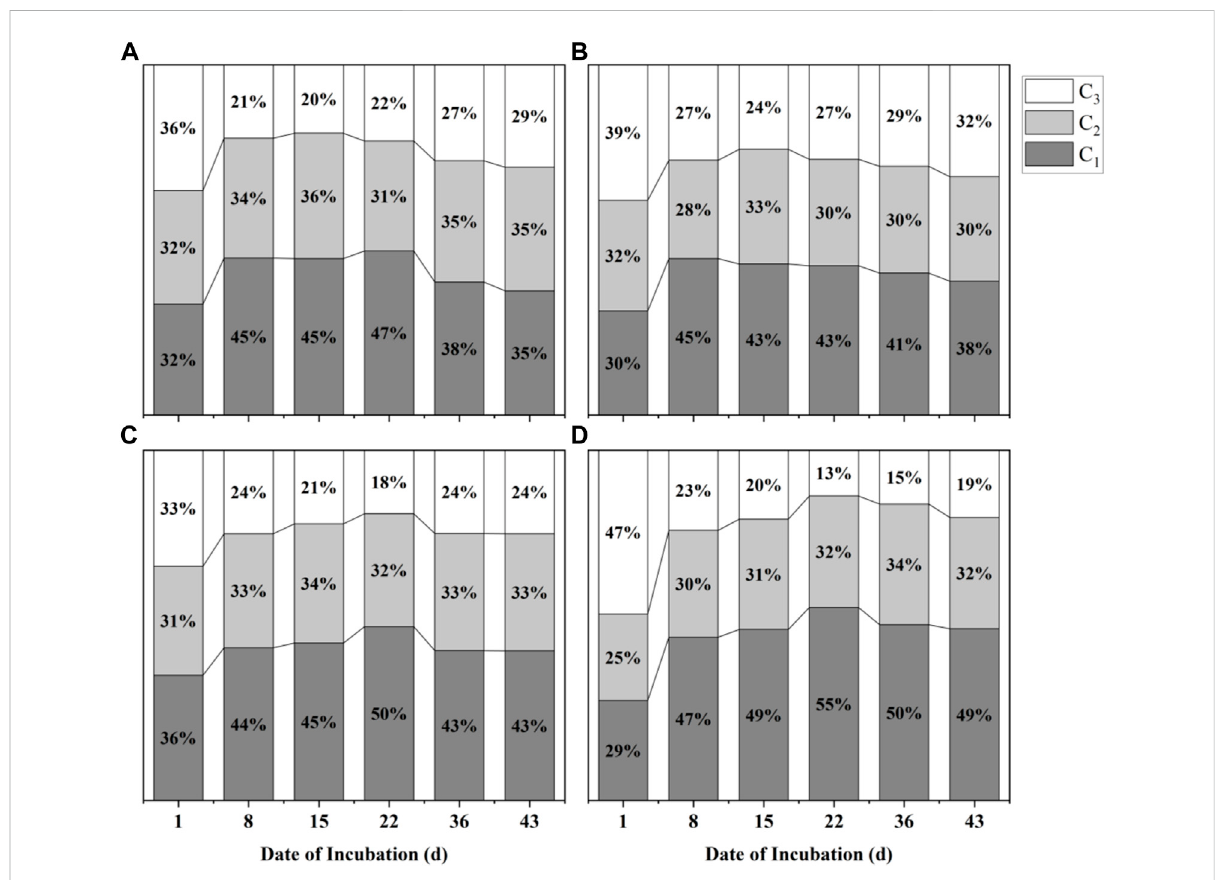
FIGURE 5 Temporal variation of organic components (%; C 1 , C 2 and C 3 ) from four sediments are plotted against time, where (A – D) represent the Chu River riparian sediment, Hongshan Gate sediment, Fish pond interchange sediment and Zero-interchange fi sh pond